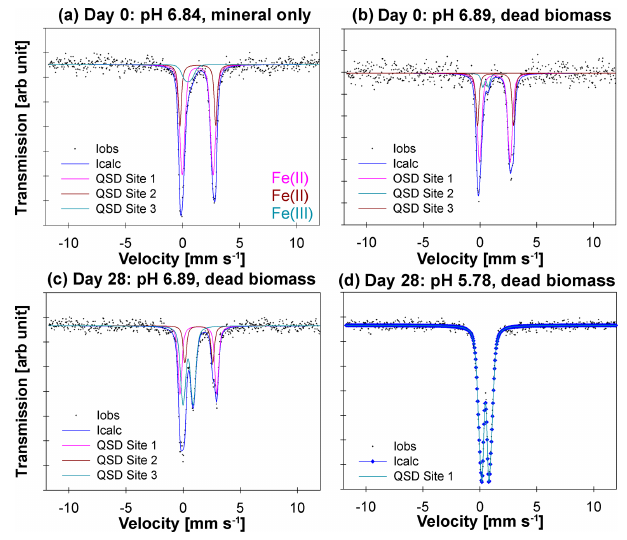
Figure 3. 57 Fe Mössbauer spectra collected at 77 K for (a) the mineral-only set-up precipitates at Day 0 at a pH of 6.84, (b) the mineral and dead biomass amended set-up precipitates at Day 0 at a pH of 6.89, (c) the mineral and dead biomass amended set-up pre- cipitates at Day 28 at a pH of 6.89, and (d) the mineral and dead biomass amended set-up precipitates at Day 28 at a pH of 5.78. Full lines represent the calculated spectra and their sums. Colours of the fits represent the corresponding Fe phase and, thus, vary between the graphs: Fe(II) doublets, ( a, c – QSD sites 1 and 2; b – QSD sites 1 and 3) closely match the spectra known for vivianite. Minor amounts of Fe(III) are present at Day 0 in both the mineral-only and DB-amended set-ups ( a, b – QSD Site 3/2). Single doublets shown in panels (c) (QSD Site 3) and (d) (QSD Site 1) correspond to a poorly ordered Fe(III) mineral such as